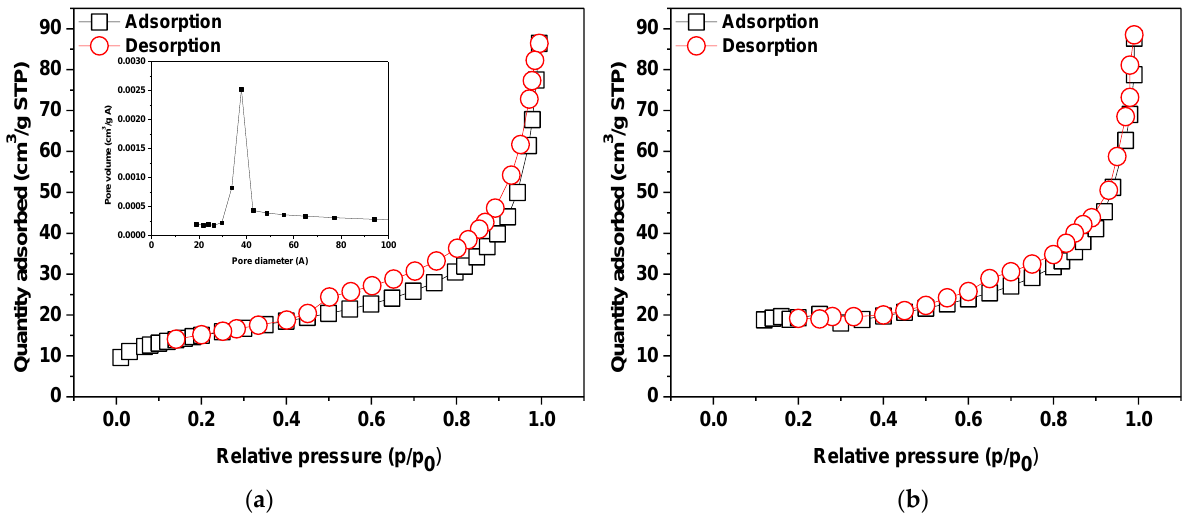
Figure 3. N 2 adsorption–desorption isotherms at 77 K and BJH desorption pore size distribution of ( a ) NaP1CS and ( b ) NAP1H.